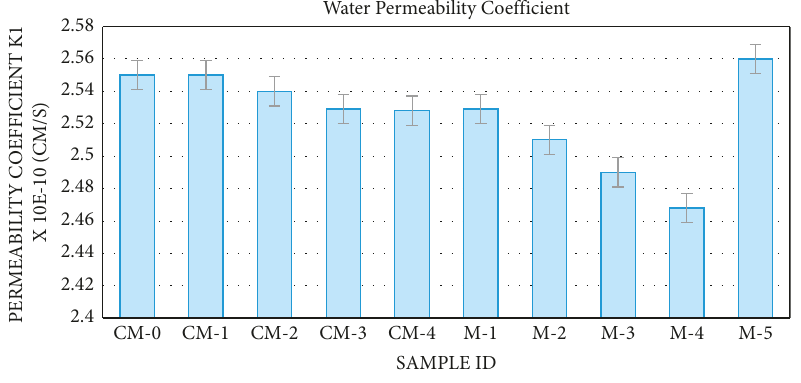
Figure 12: Water permeability of concrete.